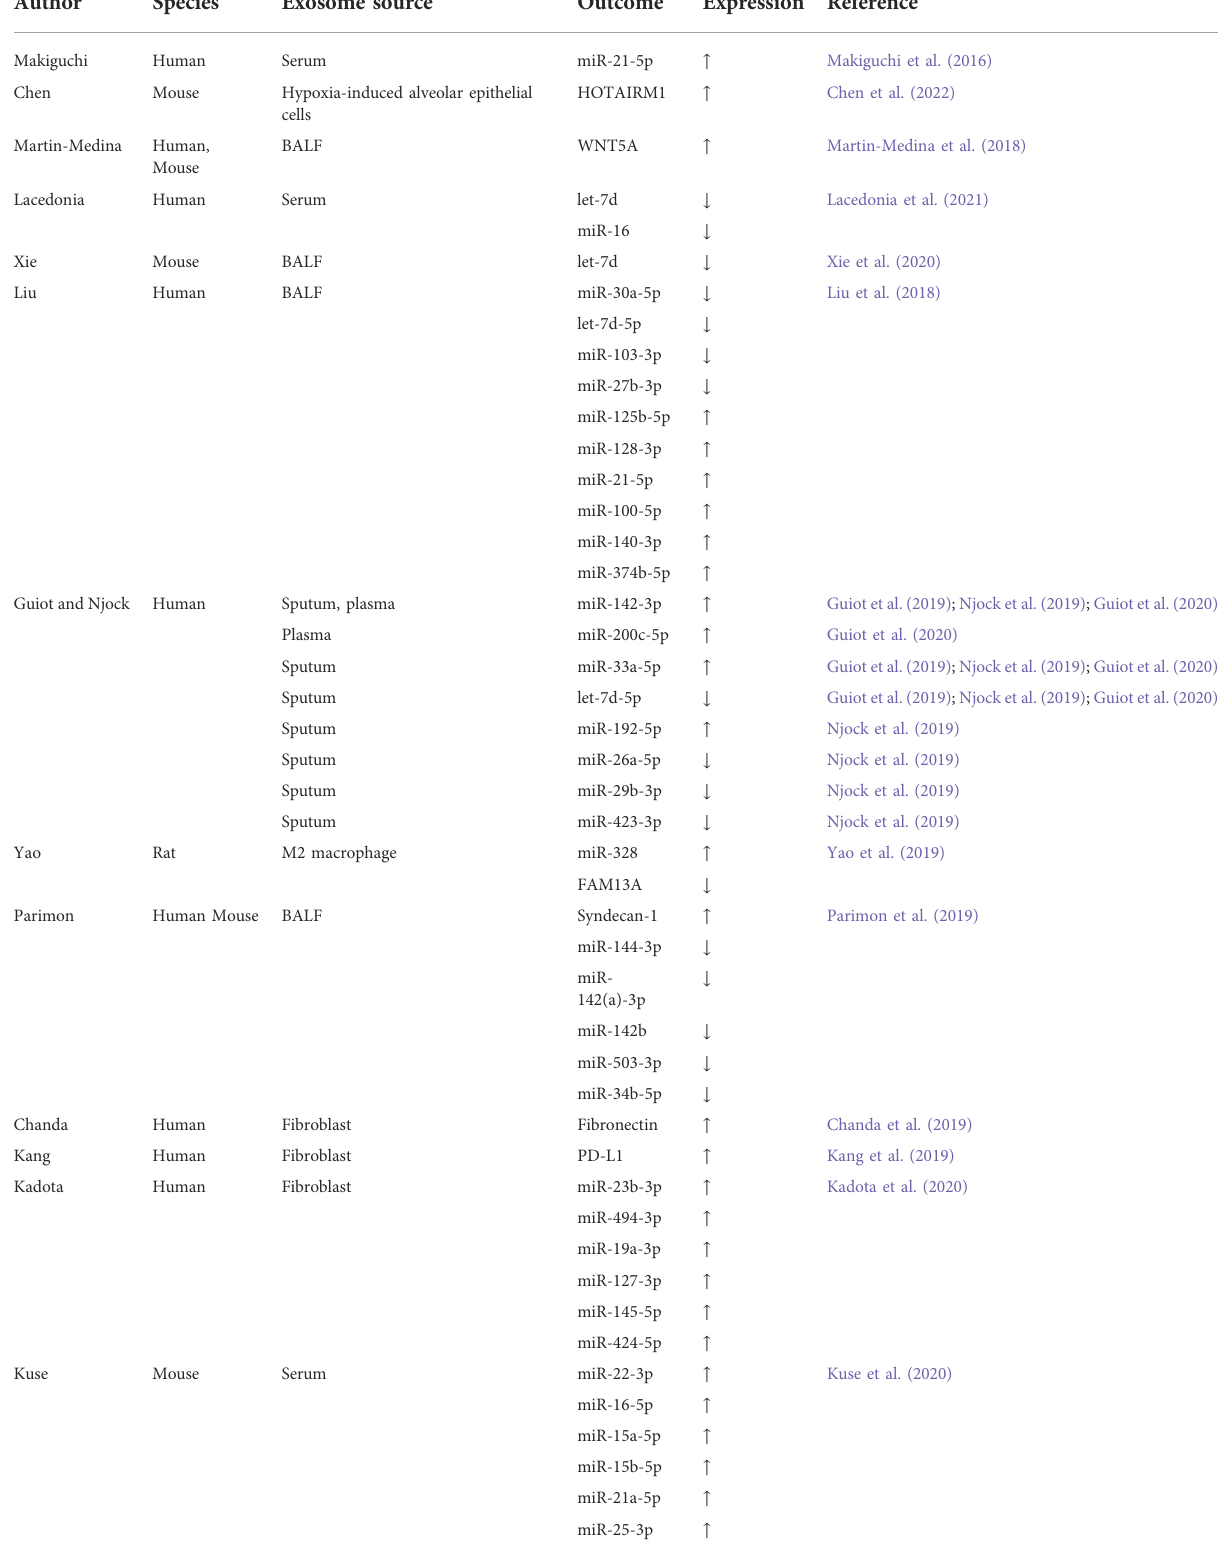
TABLE 1 Exosomes associated with pulmonary fi